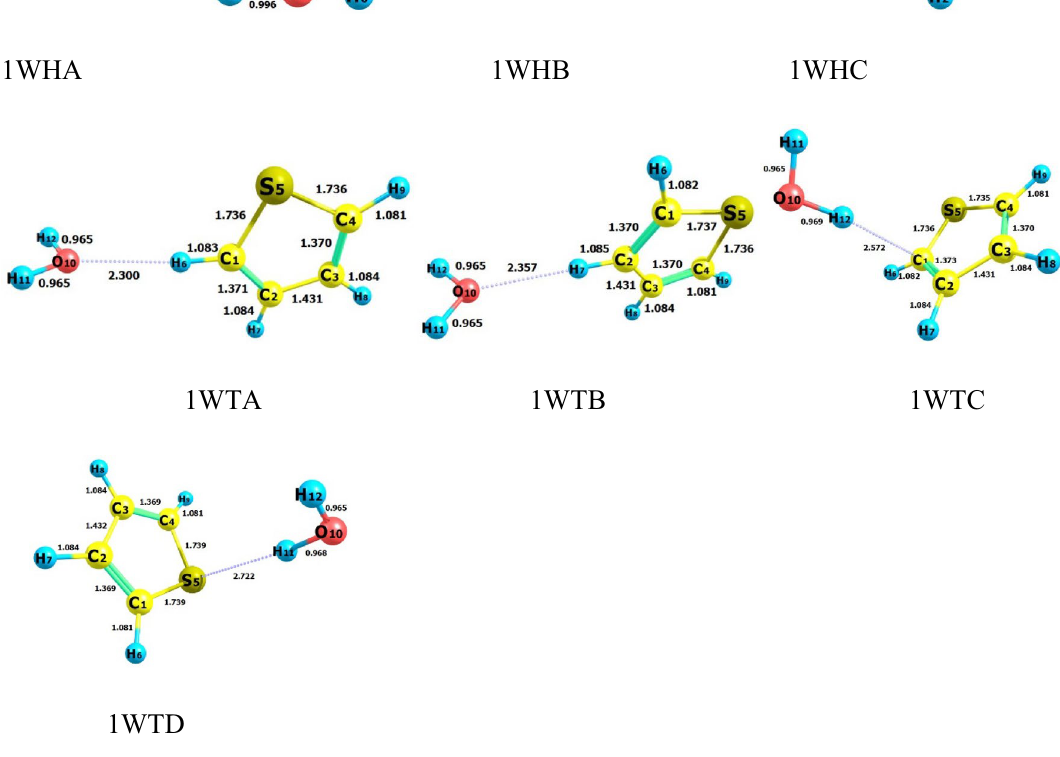
Figure 1. Possible complexes established between hydroperoxyl radical and water molecules, and also thiophene and water molecules (unit of all distances is